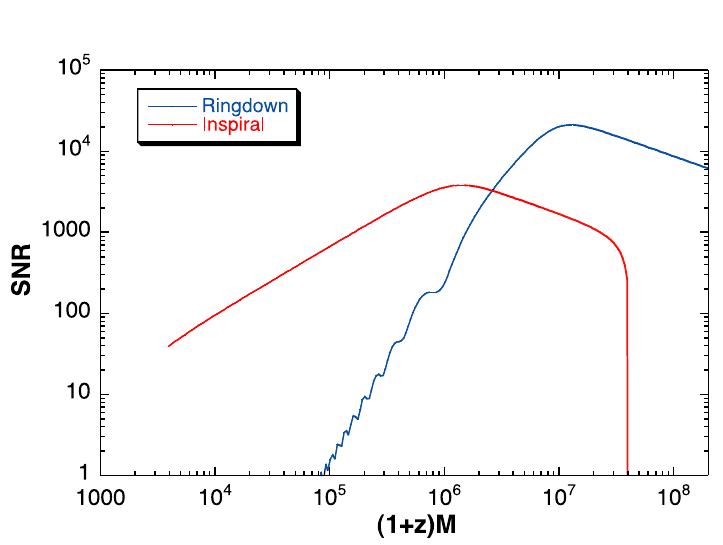
Figure 8: Comparative SNRs, as a function of redshifted black-hole mass (1 + 𝑧 ) 𝑀 , for the last year of inspiral of an equal-mass MBH binary and for the ringdown after the merger of the system. The method used to generate this figure follows that of [182], updated to use a modern LISA sensitivity curve [277] with a low-frequency cutoff of 𝑓 = 1 × 10 − 4 Hz. The redshift is set to 𝑧 = 1, at which the luminosity distance is 𝐷 𝐿 = 6 . 6 Gpc using WMAP 7-year parameters